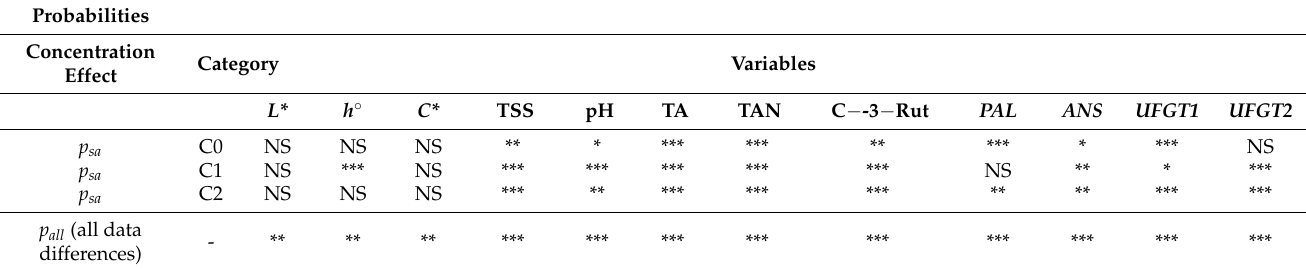
Figure 1. Frequency of cracking categories (%), in year 1 ( a ) and year 2 ( b ), in fig peel after preharvest treatment with different concentrations of salicylic acid (SA). The effect of concentration was highly significant in both experiments, according to the Wilcoxon/Kruskal–Wallis χ 2 test ( p < 0.001). Values among or between SA concentrations in ( a ) or ( b ), respectively, which share a common lowercase letter do not differ significantly. In each category, data analyzed by one-way ANOVA showed the concentration effect: year 1: C0, p < 0.001; C1, p < 0.01; C2, p < 0.001; and year 2: C0, p < 0.001; C3, p < 0.001. Table 2. Probabilities of the effect of preharvest treatment with different concentrations of salicylic acid (SA) on L*, h ◦ , C*, TSS, pH, and TA in fig flesh and TAN, C-3-rut, PAL , ANS , UFGT1 , and UFGT2 in fig peel in each cracking category (C0, C1, C2) and of all data differences on the same variables, in year